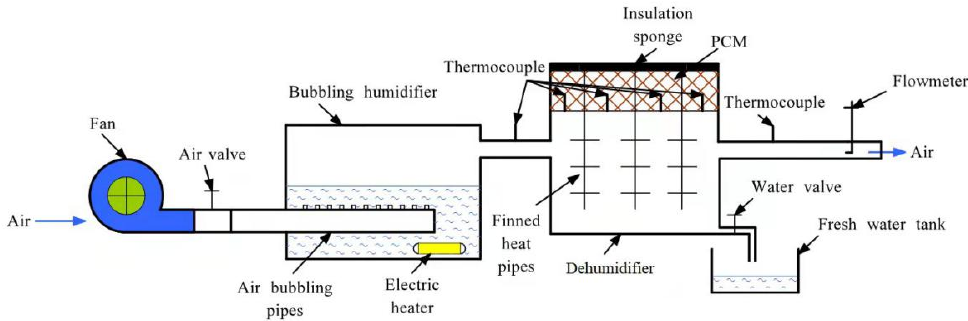
Figure 2. Schematic diagram of the phase change heat storage dehumidifier experimental system.